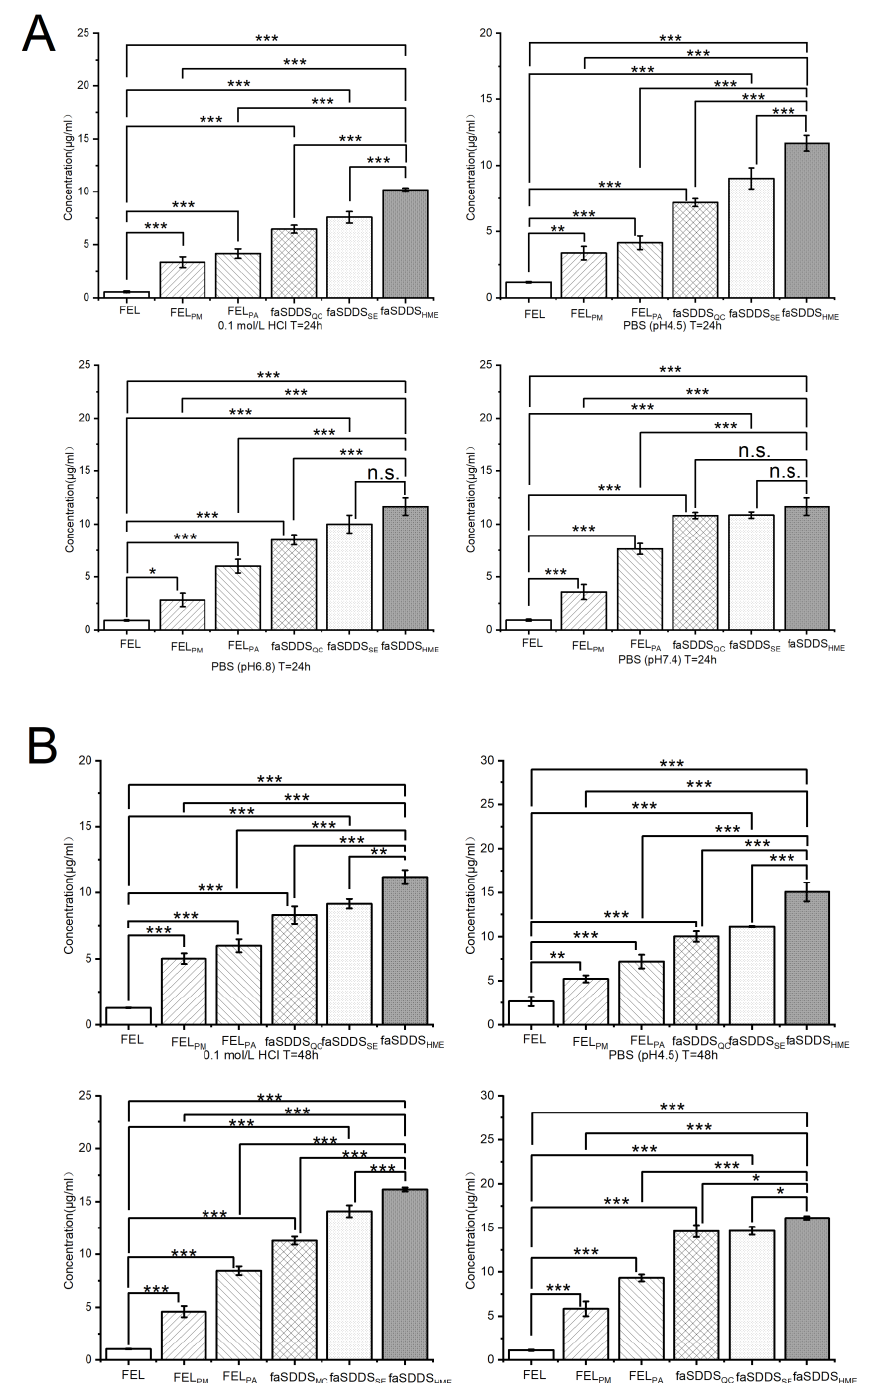
Figure 6. Solubility of samples in different solutions (0.1 mol/L HCl and PBS (pH 4.5, 6.8, 7.5)) at 24 h ( A ) and 48 h ( B ); * p < 0.05, ** p < 0.01, *** p < 0.001, and NS, no significant difference. Standard deviation expressed by error bars (n = 3).